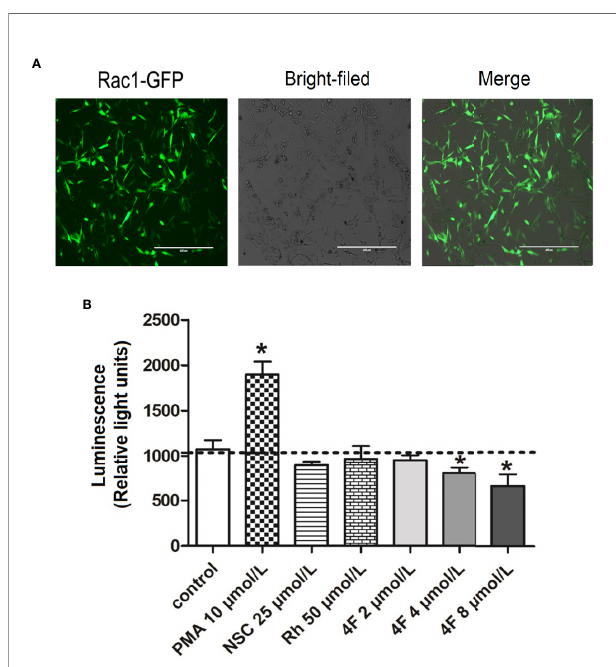
FIGURE 6 | Luciferase activity of Rac1 promoter in MDA-MB-231 cells treated with different compounds. (A) GFP-labeled MDA-MB-231 cells following Rac1- promoter-Luc2 lentivirus transfection (scale bar: 400 m m). Under an inverted fl uorescence microscope, almost all cells show green fl uorescence with moderate intensity with a fl uorescent cell count indicating a 90% transfection ef fi ciency. (B) Luciferase activity of Rac1. Data are shown as means ± SD (n = 3). One-way analysis of variance (ANOVA) was used for statistical analysis. * P < 0.05, comparison of each compound group and control